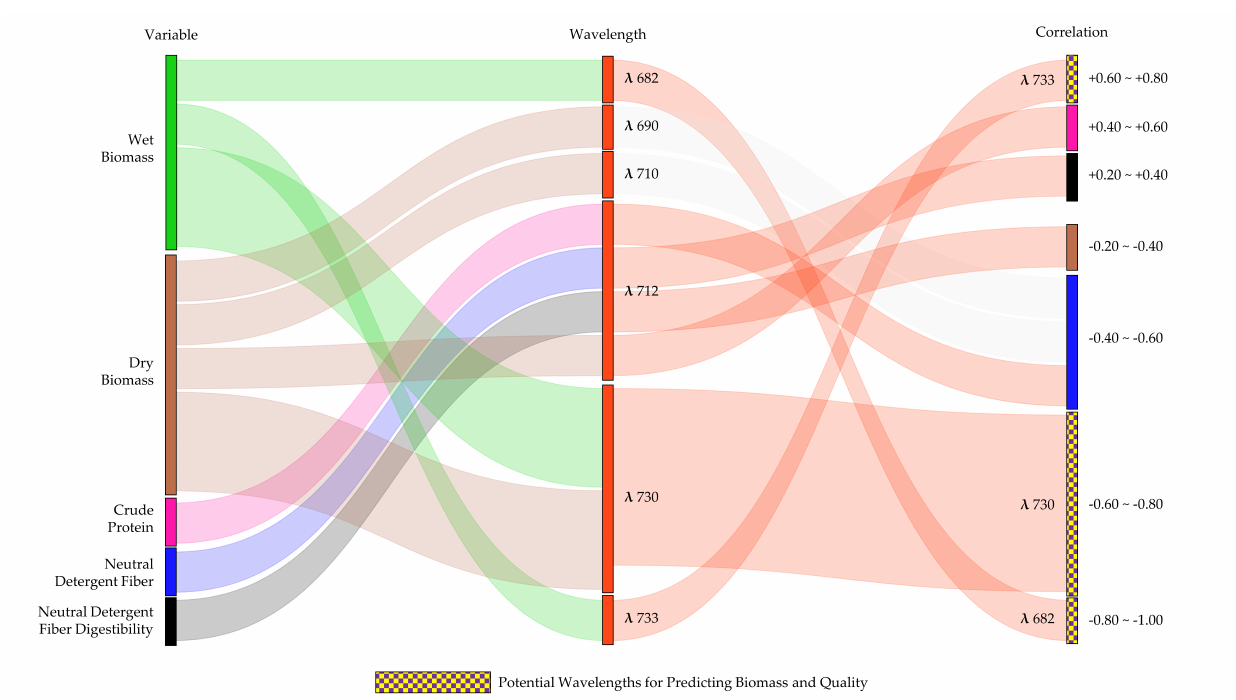
Figure A4. Sankey diagram illustrates the wavelengths in the red edge region ( λ 680 − 730) most correlated with alfalfa biomass and quality traits. The flow chart intuitively displays bars and paths drawn in proportion to the amount of information used. The larger the bars, the more times this information has been used. Colored pathways assign the connections between alfalfa biomass and quality traits and its usage in remote sensing data (i.e., wavelengths or vegetation indices) as well as its response to the strength of the correlation. When wavelength or vegetation indices have the potential to be used to establish a relationship with biomass and quality traits, they are marked. The colors of each correlation bar are linked to the biomass and quality traits. When it is white, it is because it has no potential to be used. However, when the bar is colored and checkered, it indicates that although it has not been used to study its relationship with quality, it has the potential to predict it assuming its correlation with